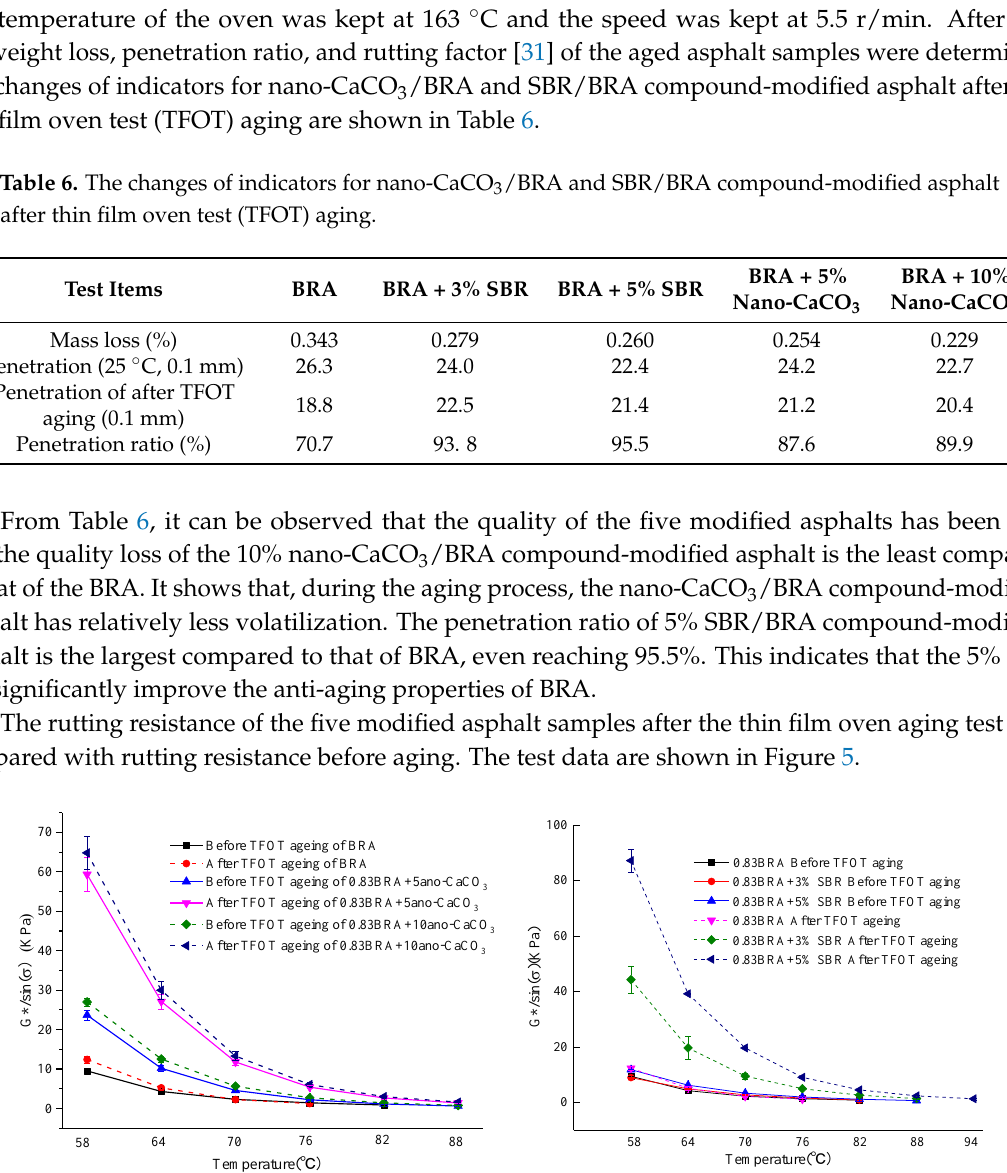
Figure 5. The relationship between Nano-CaCO 3 /BRA and SBR/BRA compound-modified asphalt in before and after thin film oven test (TFOT) aging anti-rutting factors ( G* /sin δ ) and temperature.